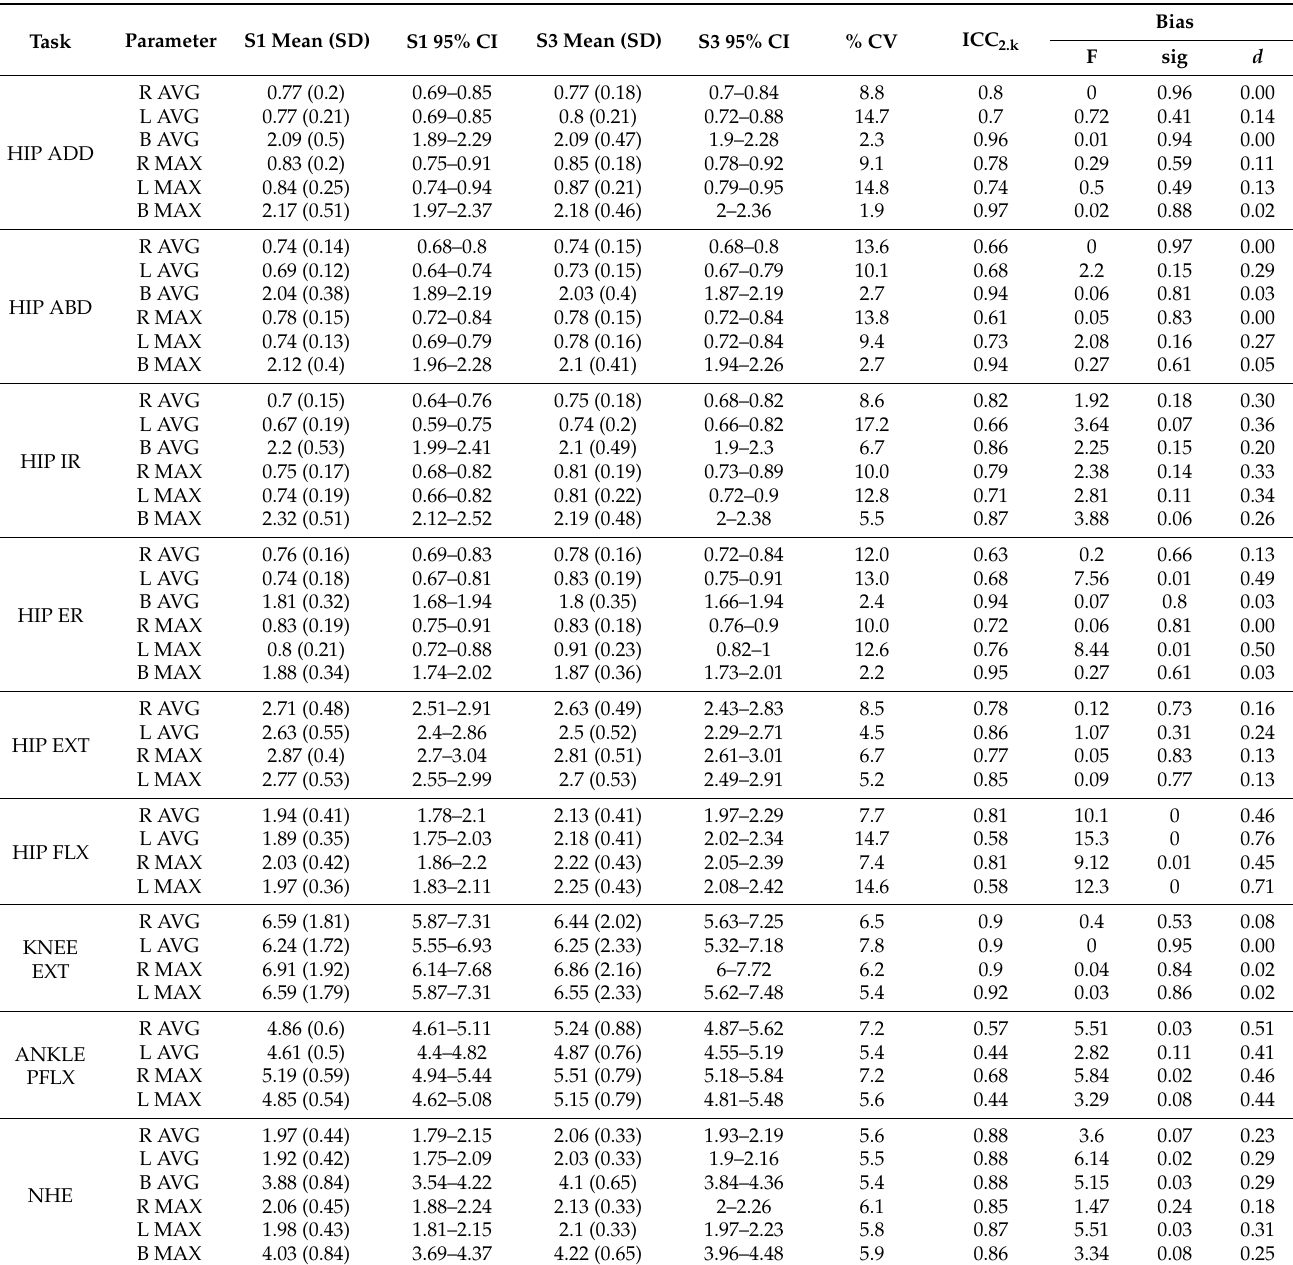
Table 4. Inter-session reliability–peak torque